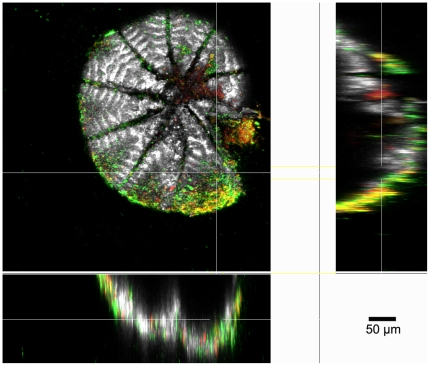
CLSM image of foraminifera shell incubated in non-sterile, dissolution experiment.Bacteria (green) can clearly be seen colonising the shell. Also visible are lectin-stained EPS glycoconjugates (red). Orange/yellow (overlay of green and red) denotes colocalized signal by SYTO9 nucleic acid stain and Aleuria aurantia lectin stain. A) Maximum intensity projection of the whole image series. B) Extended XYZ projection of the same data set. The elongated signals in axial direction (XZ and YZ) are due to the low numerical aperture lens used for imaging the whole foraminifera shell. Bar size: 50 µm.